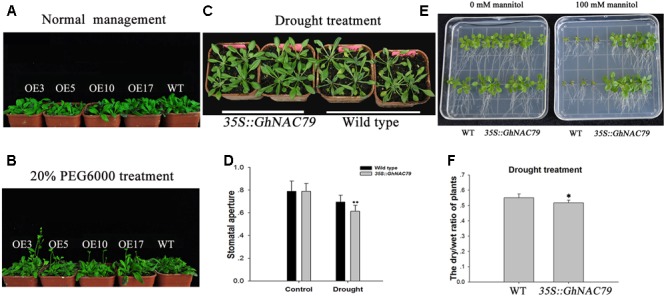
Overexpression of GhNAC79 in Arabidopsis enhanced drought tolerance. (A,B) Plants were treated with 20% PEG6000 at 20 days after sowing; wild type represents the wild type, and OE3, OE5, OE10, and OE17 represent the four lines of transgenic Arabidopsis. (A) Phenotypes of transgenic Arabidopsis and wild type under normal management. (B) Phenotypes of all plants after drought treatment. (C,D) Transgenic plants and wild type were treated with 20% PEG6000 at 14 days after sowing. (C) Phenotypes of transgenic plants and wild type. (D) Stomatal aperture of transgenic Arabidopsis and wild type. (E) Phenotypes of transgenic Arabidopsis and wild type after treatment with 100 mM mannitol in 1/2 MS medium. (F) Differences in dry/wet ratios between transgenic plants and the wild type after mannitol treatment. ∗Values significantly different from wild type at the 0.05 confidence level. ∗∗Values significantly different from wild type at the 0.01 confidence level.